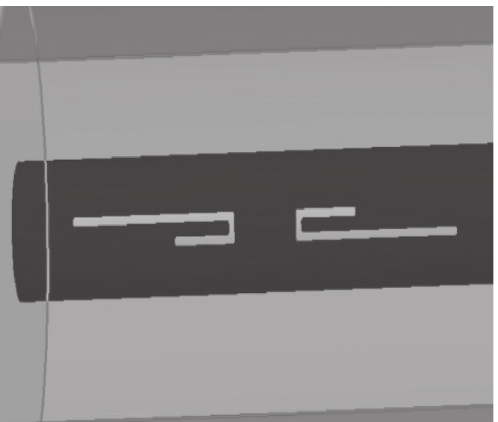
Figure 11: Schematic diagram of simulated groove for curved hook-groove leakage cable.